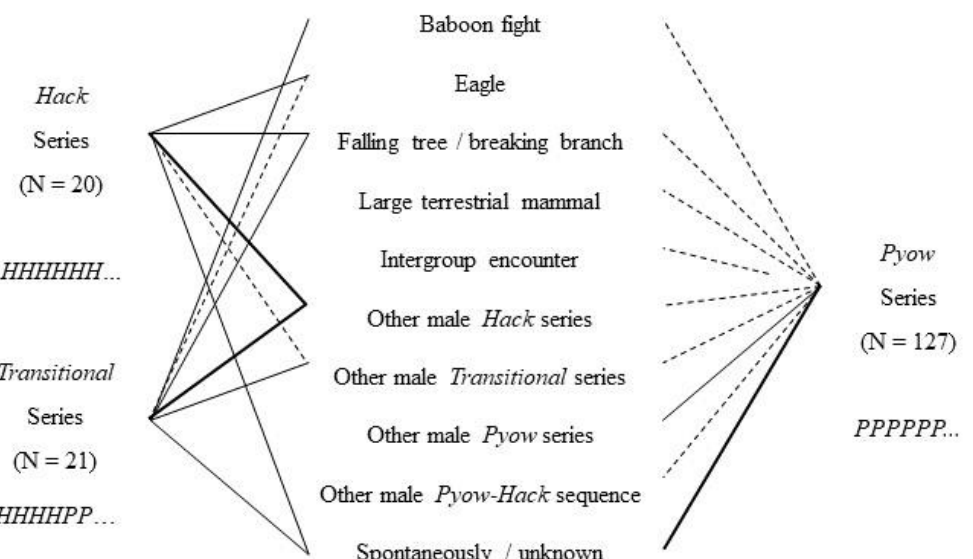
Figure 1 The natural contexts in which hack , transitional and pyow call series were recorded over a 213-day period (Arnold & Zuberbühler, 2013). H = hack , P = pyow . The proportion of recorded call series of each type given in each context are indicated by: dashed line < 10%; solid line 11-20%; bold line >